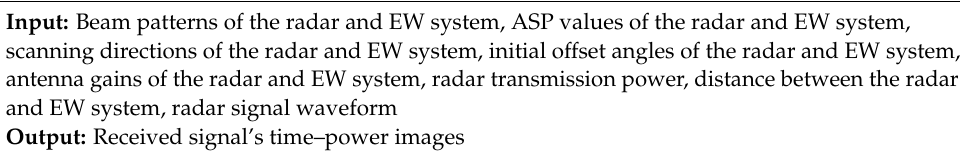
Algorithm 1 Data generation algorithm.